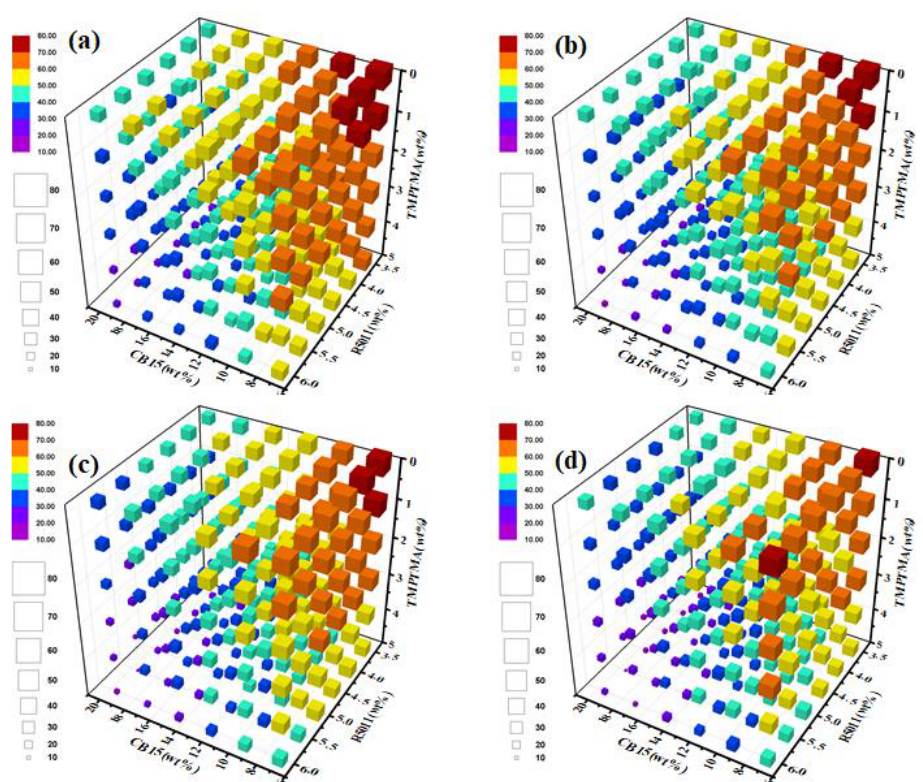
Figure 6. ( a – d ) Four-dimensional graph of the clear points with different C6M doping amount (0 wt%, 5 wt%, 7.5 wt% and 10 wt%) taking the doping amount of R5011, CB15 and TMPTMA as the coordinate axis.